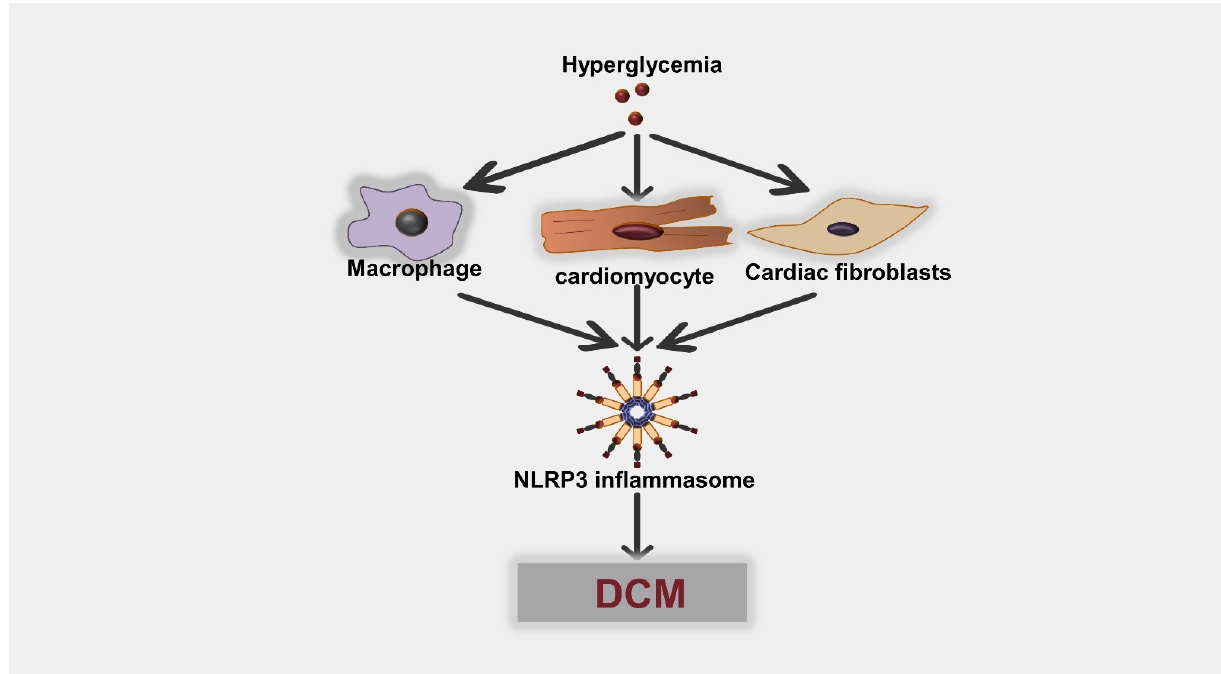
Figure 4. Hyperglycemia can cause NLRP3 inflammasome activation in different types of cells in the heart. Consequently, NLRP3 inflammasome activation and subsequent pyroptosis result in the occurrence of diabetic cardiomyopathy (DCM).